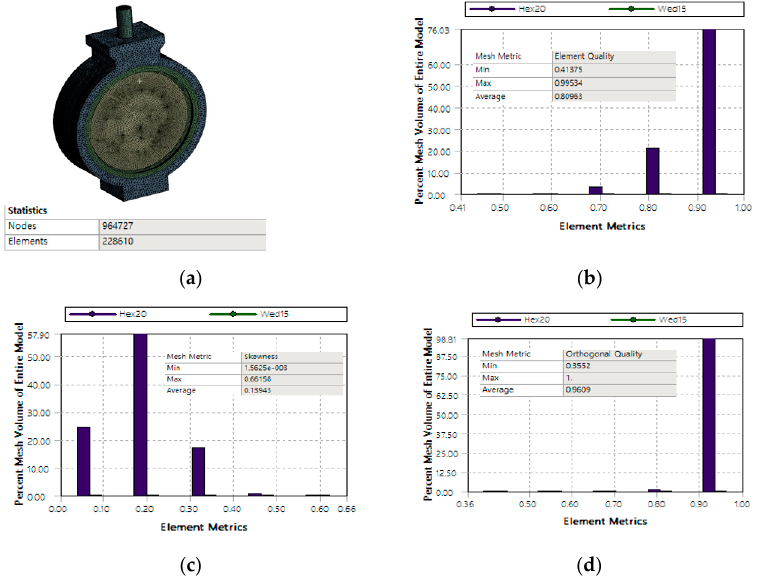
Figure 13. The mesh quality check. ( a ) generation of mesh, ( b ) element quality, ( c ) skewness, ( d ) orthogonal quality.